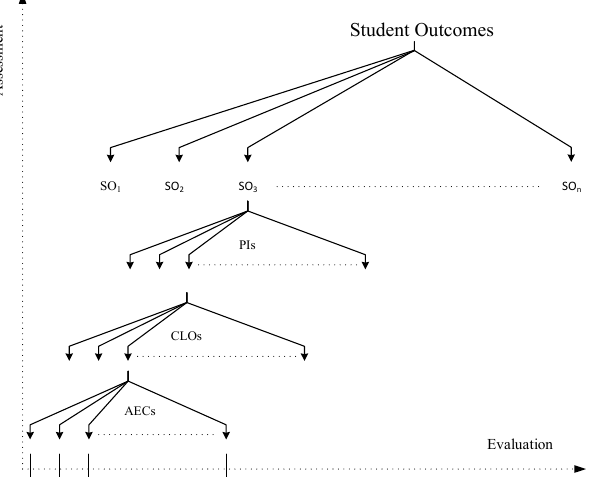
Fig. 1. The hierarchy of the unified framework for AE. Each SO is expanded into several PIs; assessment of the PI is carried out using careful mapping of a selected set of CLOs from a large bouquet of courses. Assessment of CLOs is carried out using a weighted average of selected AECs in a